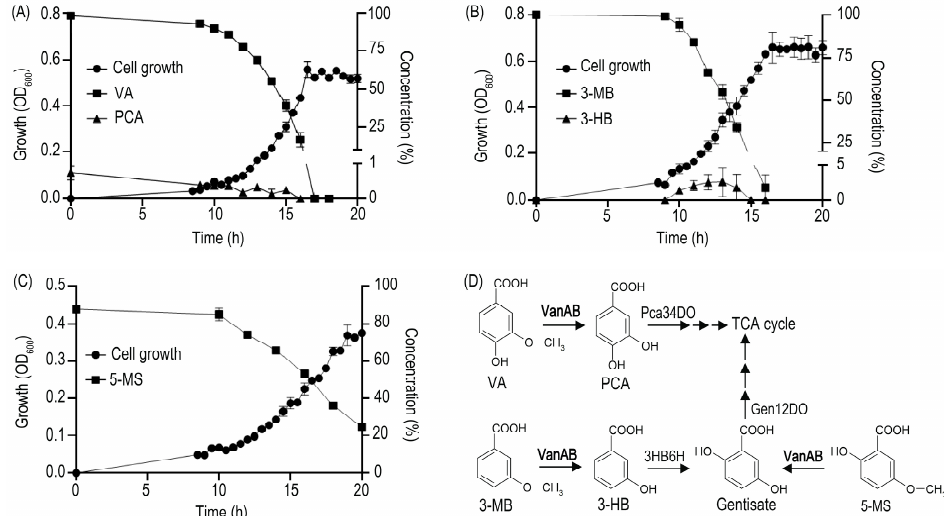
Figure 1. Growth curves of Rhodococcus ruber R1 on VA and analogs as sole carbon and energy sources, and their channeling into catabolic routes after O-demethylation. Growth of R1 strain on 5 mM ( A ) VA, ( B ) 3-MB, and ( C ) 5-MS as sole carbon and energy sources. Detection of ( A ) PCA and ( B ) 3-HB indicates O-demethylation activity in degradation of VA and 3-MB, respectively. In ( C ) 5-MS-grown cells, its O-demethylation product (gentisate) was not detected, suggesting rapid and efficient gentisate turnover in R1 strain. ( D ) Catabolic pathways for VA, 3-MB, and 5-MS predicted from inspection of R. ruber R1 genome. The first step in the VA degradation pathway is O-demethylation into the dihydroxylated intermediate protocatechuate (PCA), employing the vanAB -encoded enzyme (VanAB) as reported in Rhodococcus jostii RHA1 [11]. On the other hand, the O-demethylation of 3-MB could generate 3-HB, that is converted by action of a flavoprotein hydroxylase (3HB6H) into gentisate; which in turn, is the putative product of 5-MS O-demethylation. The route for 3-HB turnover through gentisate has been previously described in R. jostii RHA1 [38,39]. VanAB, Vanillate O-demethylase; Pca34DO, protocatechuate 3,4-dioxygenase; 3HB6H, 3-hydroxybenzoate 6-hydroxylase; Gen12DO, gentisate 1,2-dioxygenase; TCA, tricarboxylic acid. Optical density at 600 nm (closed circles); and the concentrations (%) of VA, 3-MB or 5-MS (closed squares), and PCA or 3-HB (closed triangles) are depicted in the figure. Concentrations are represented as percentages of the initial substrate concentration. Three biological replicates were performed for growth measurements. Error bars indicate SEM.